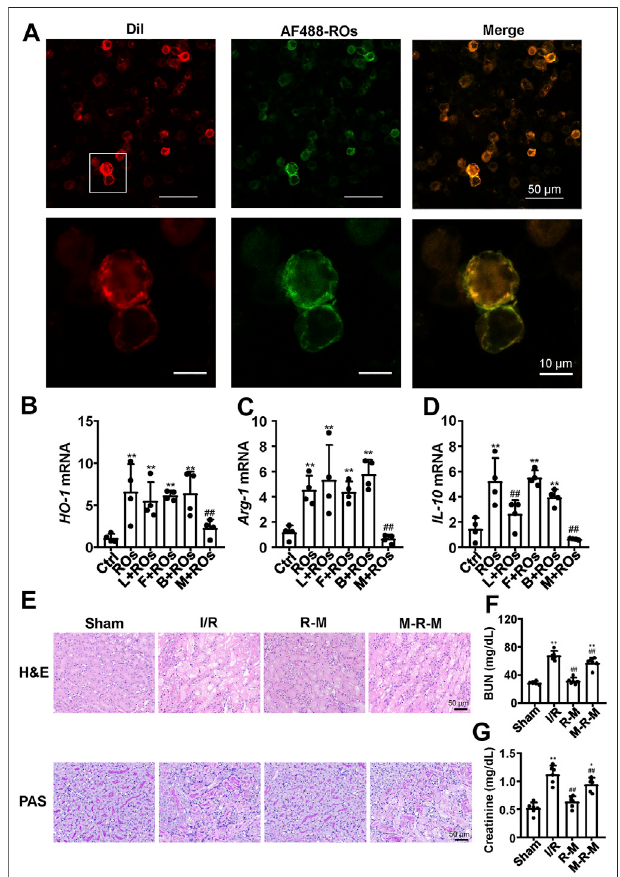
FIGURE 7 | Interfering with mDC-SIGN blocked the riclinoctaose function (A) Colocalization of AF488-labeled riclinoctaose and cell membrane dye. Raw 267.4 cells were incubated with AF488-riclinoctaose for 6 h, then strainedforconfocalmicroscopywithDiI(redcellmembrane dye). (B – D) mRNA expression levels of HO-1 , Arg-1 ,and IL-10 in BMDMs pretreated with vehicle,laminarin(200 μ g/ml),Fcblock(10 μ g/ml),bartonellaLPS(160 ng/ml), or mannan (200 μ g/ml) before riclinoctaose-treatment (300 μ M). (E) Upper panel: representative kidney section stained for hematoxylin and eosin (H and E) in sham mice, I/R mice, mice treated with riclinoctaose (R – M), and mice treated with riclinoctaose and mannan (M-R-M). Lower panel: representative kidney section stained with Periodic acid – Schiff (PAS) in each mice group. (F-G) Blood urea nitrogen (BUN) levels and serum levels of creatinine in each mice group. Ctrl: Control, ROs: Riclinoctaose. Data are expressed as mean ± SD. n (cid:1) 6, * p < 0.05, ** p < 0.01 compared with the sham group or control group;# p < 0.05,## p < 0.01comparedwiththeI/RgrouporROsgroup.Data were analyzed by the two-way ANOVA followed by Bonferroni post